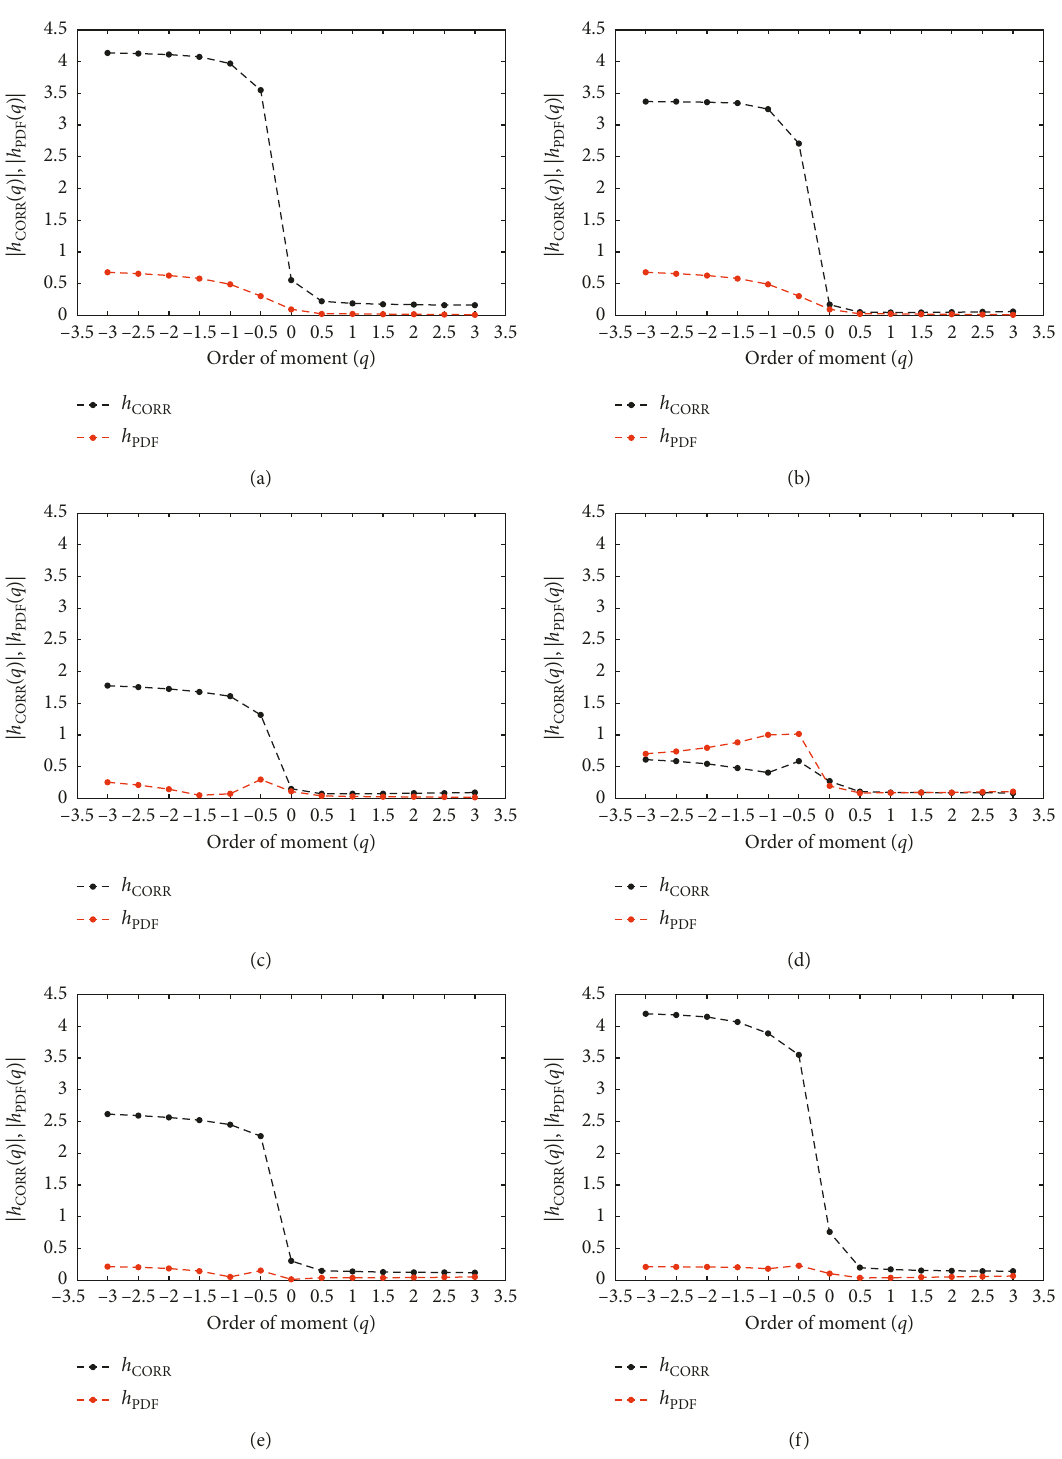
( q )| and | h ( q )| as a function of ( q ) (where q ) is the order of the fluctuation CORR PDF